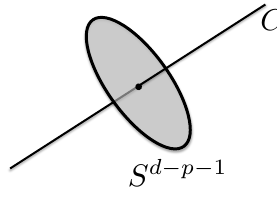
Figure 1: Geometry for Goldstone theorem: C is an infinite p -plane that